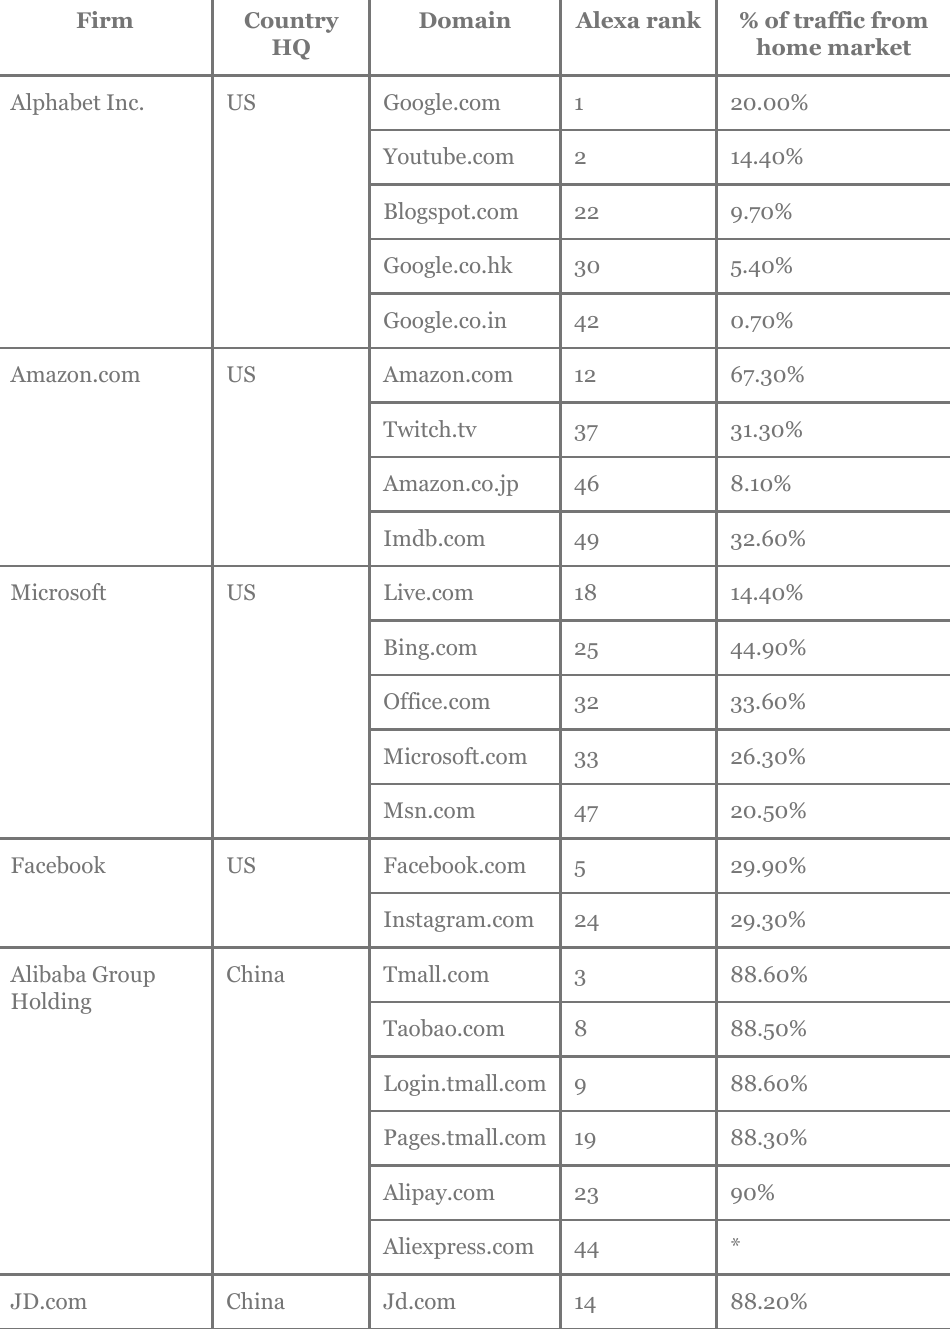
Table 2: Top internet firms by